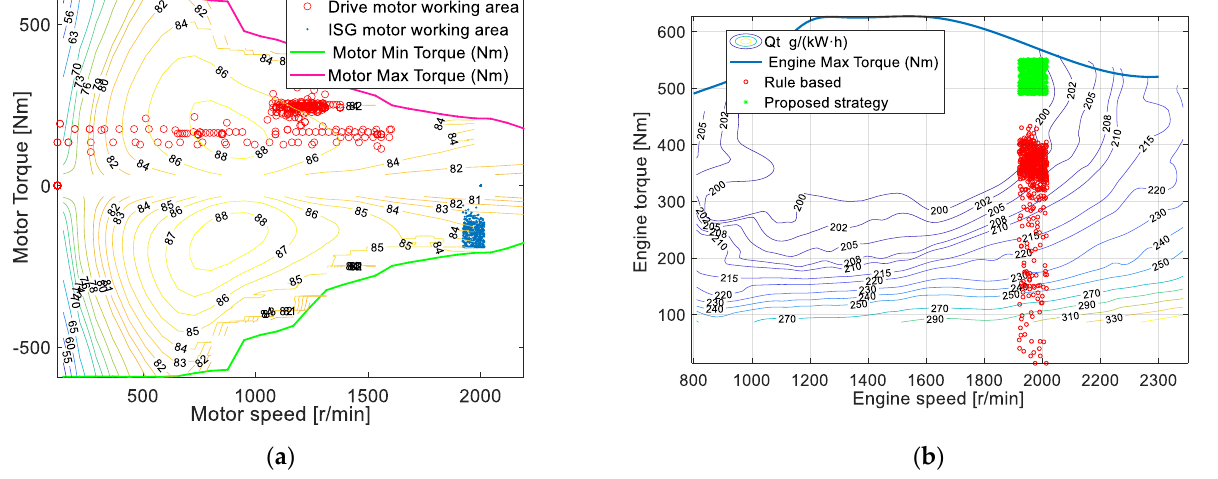
Figure 10. The working area of power units. ( a ) The working area of motors in rotary tillage. ( b ) The working area of the engine in rotary tillage.